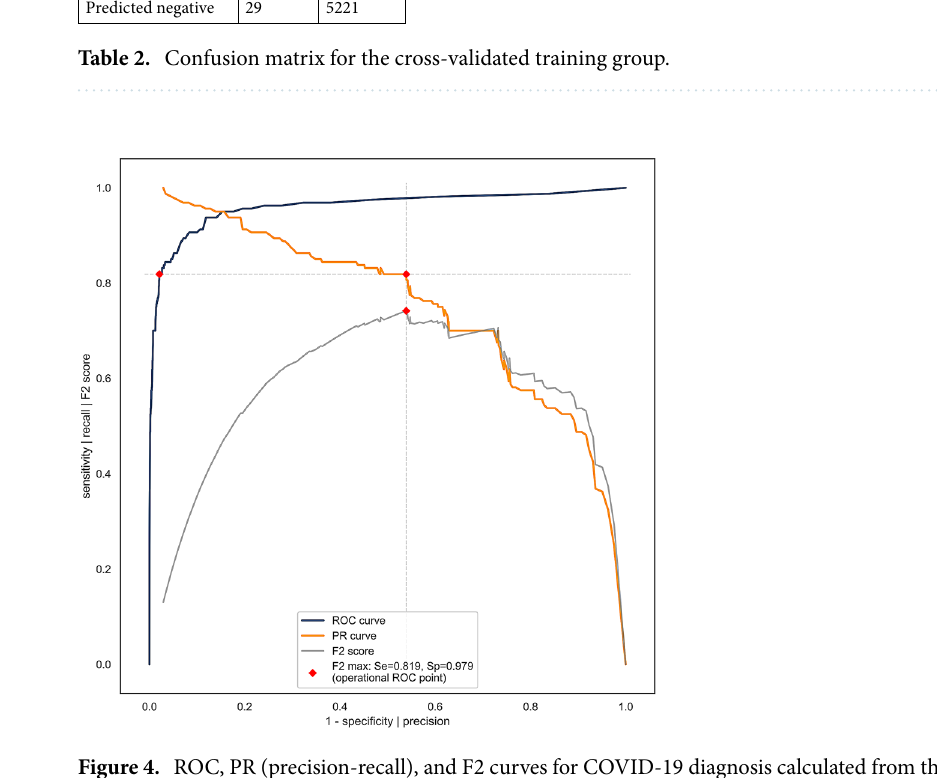
Figure 4. ROC, PR (precision-recall), and F2 curves for COVID-19 diagnosis calculated from the training data using ten-fold stratified cross-validation. Vertical and horizontal dashed lines connect the F2 (gray) max point with the PR curve (orange) and the ROC curve (blue) in order to obtain the operational ROC point with sensitivity = 0.819, specificity = 0.979 (depicted with red dots), and AUC =